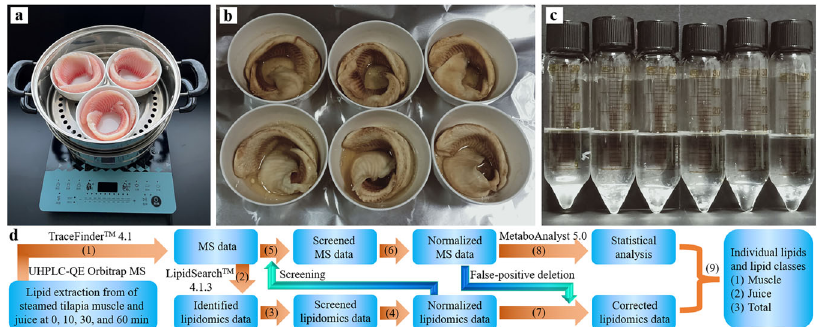
Fig. 1 Experimental and analytical process of this work. a The bowls with tilapia muscles in a pot on an induction cooker before the steaming process. b Tilapia muscles after the steaming process. Steamed tilapia muscles and juices were shown in the bowls. c Lipid extraction liquids (about 15 mL of chloroform/methanol). d Transactional analysis procedure of data from ultra-high-performance liquid chromatography coupled with Q Exactive (UHPLC-QE) Orbitrap mass spectrometry (MS). MS data indicate the data from Thermo Fisher Scienti fi c TraceFinder TM 4.1 software. Lipidomics data indicate the data from Thermo Fisher Scienti fi c LipidSearch TM 4.1.3